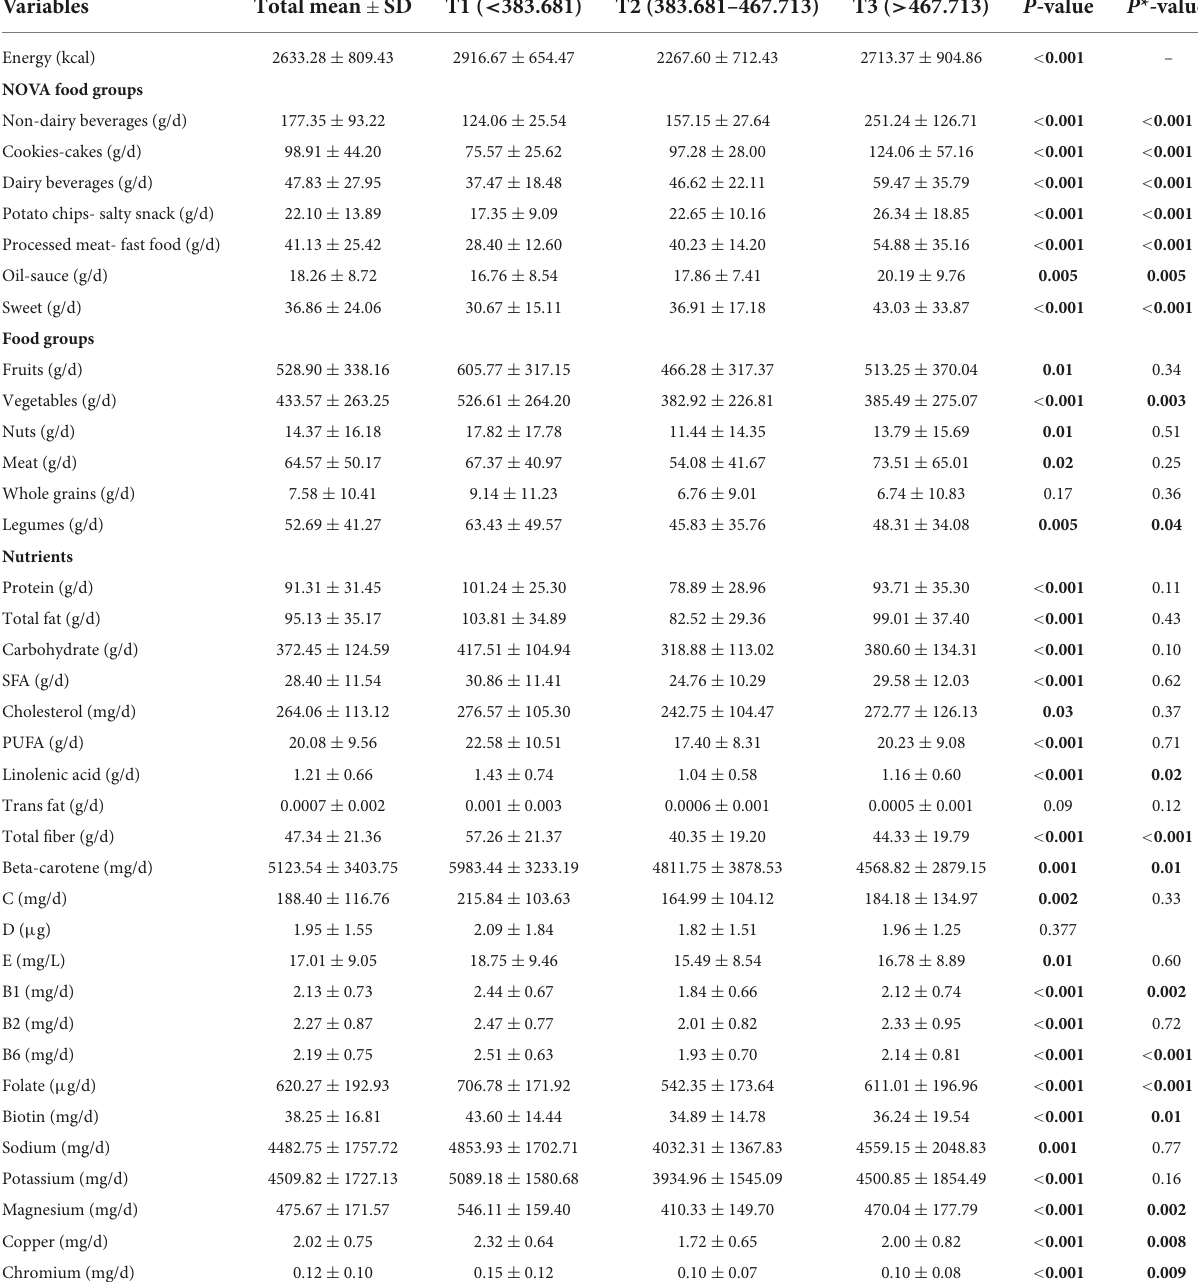
TABLE 2 Intake of UPF, food groups, and nutrients according to the UPF tertiles in overweight and obese women.